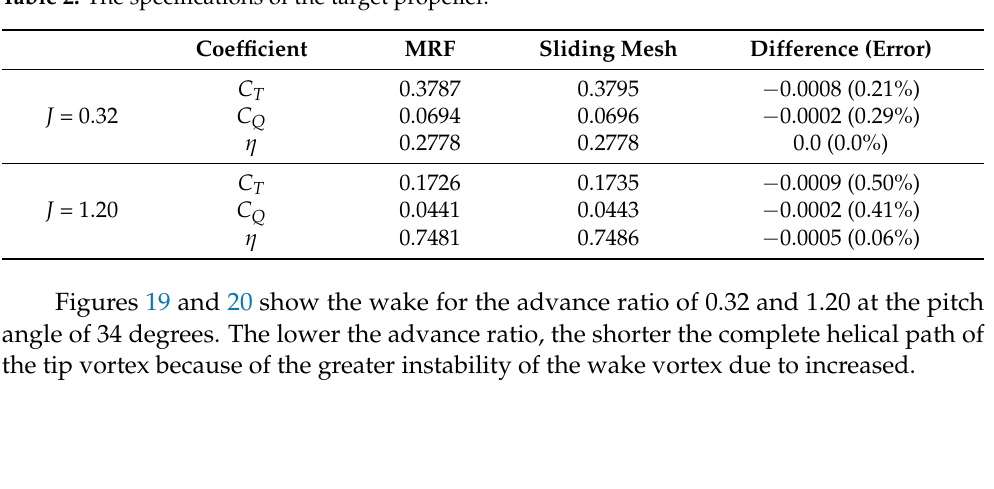
Table 2. The specifications of the target